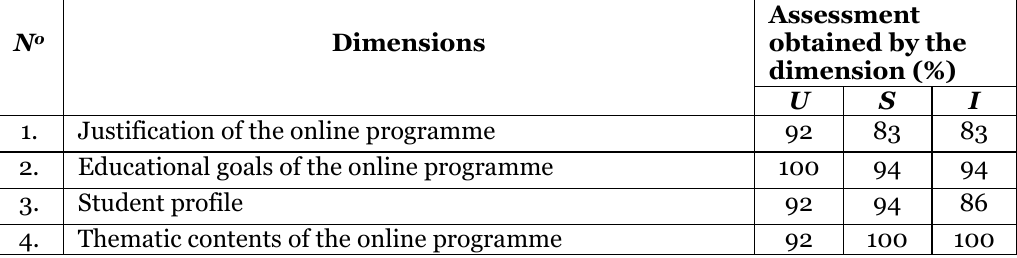
Results of the Qualitative Validation of the Dimensions of the Model